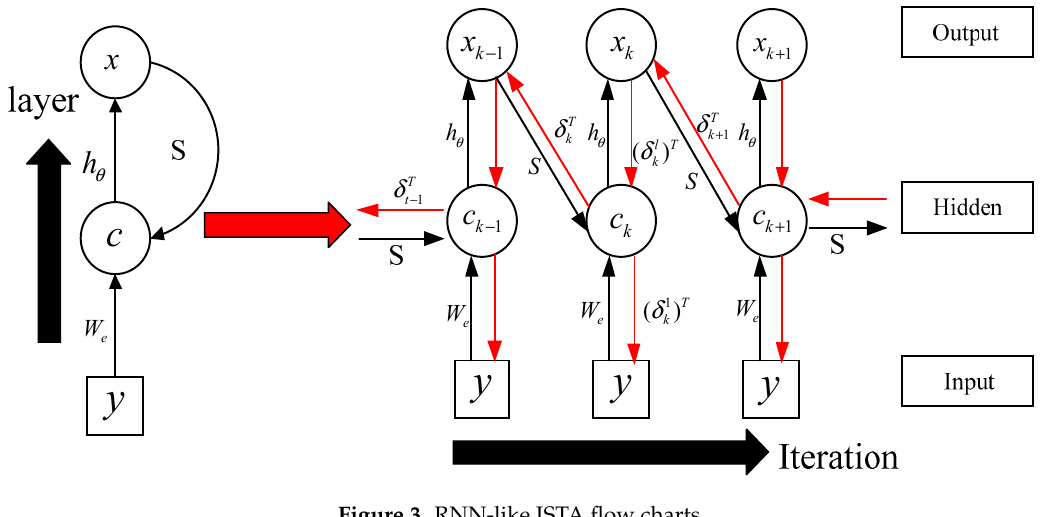
Energies 2020 , 13 , x FOR PEER REVIEW Figure 3. RNN-like ISTA flow charts. Figure 3. RNN-like ISTA flow charts.